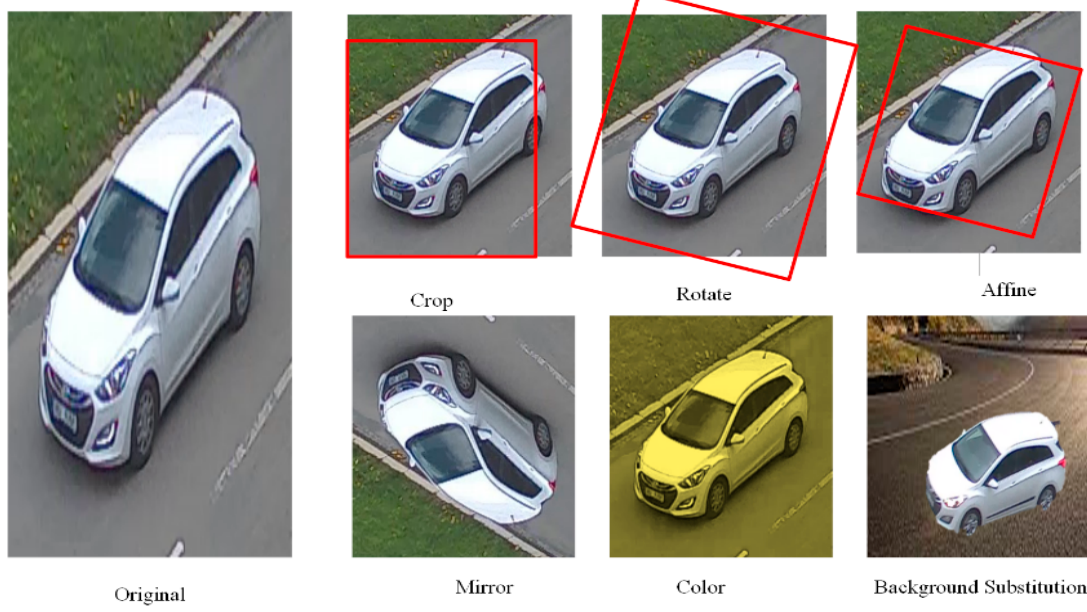
Figure 4. Illustrates of data augmentation process to add variability in training set images.